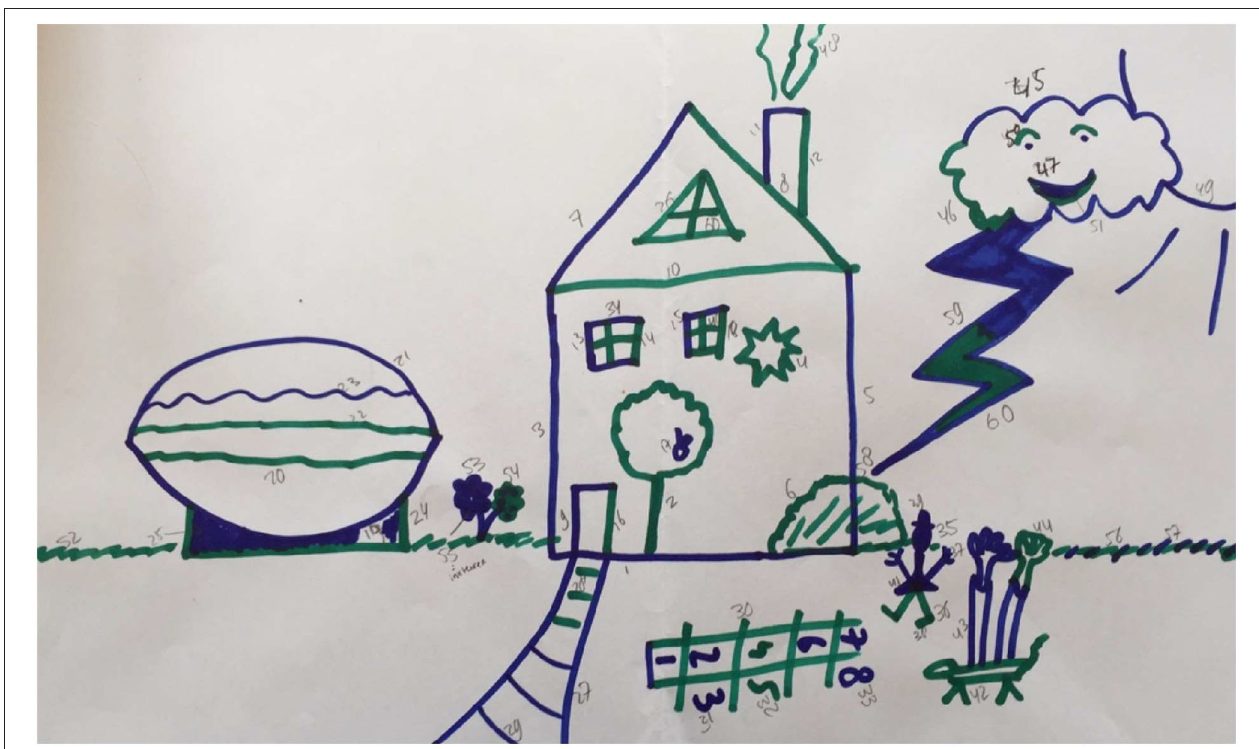
FIGURE 2 | IDT drawing by a non-autistic man (age 26 years, master degree, paid job, total AQ score: 41), who regularly contributed to the objects of the examiner.